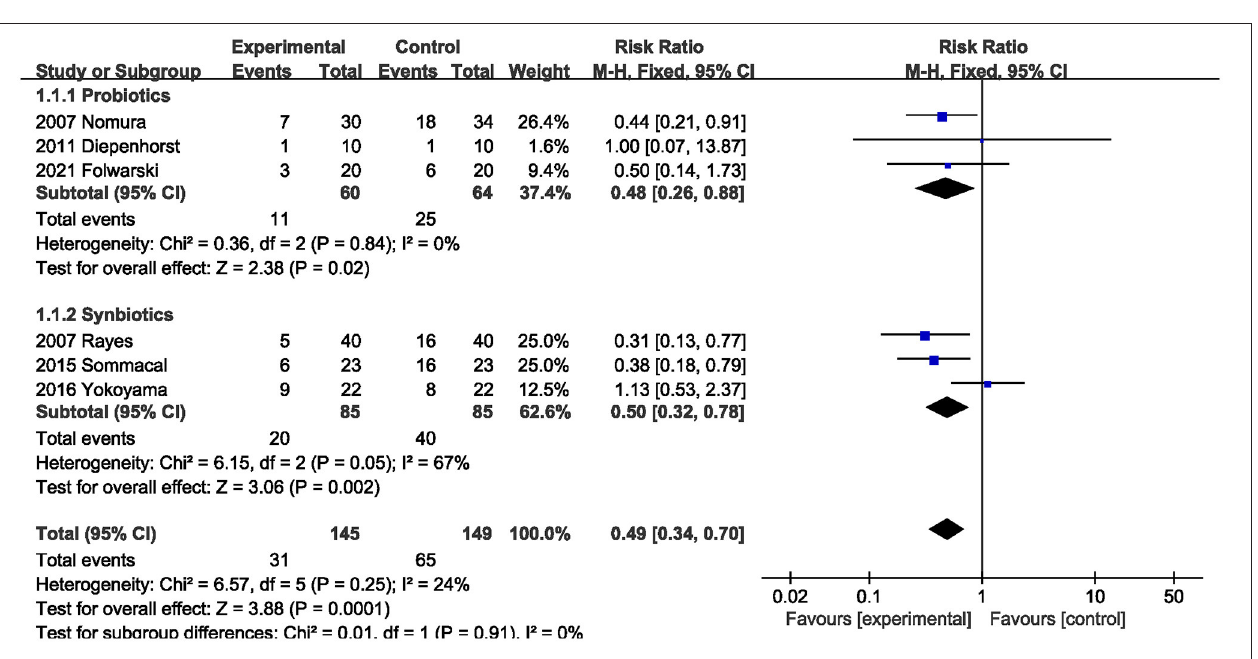
FIGURE 4 | Effect of probiotics or synbiotics supplementation on the postoperative infection